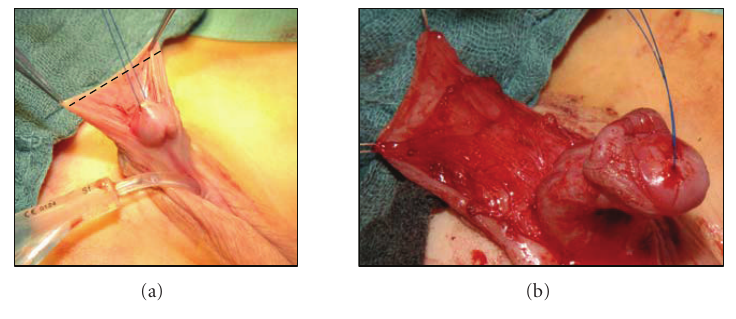
Figure 1: Preparation of the dartos